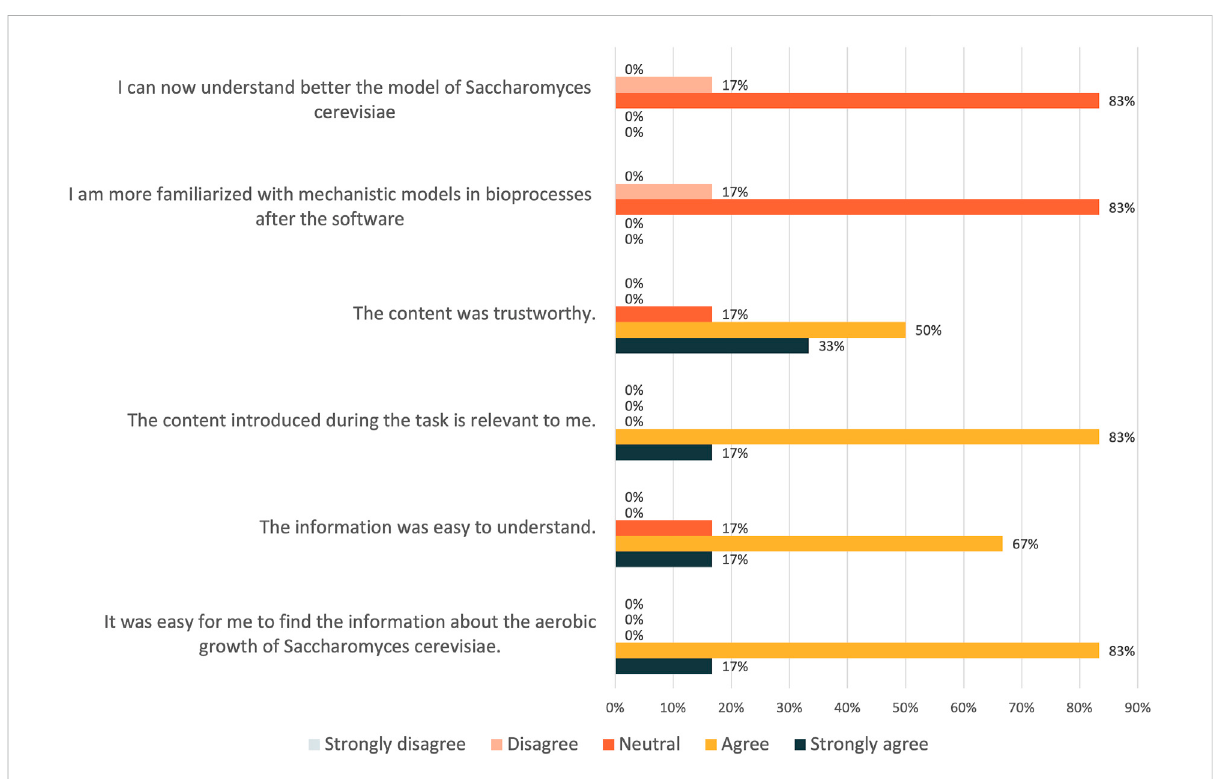
FIGURE 7 Student ’ s perspectives about the learning content provided by FermProc (later BioVL)